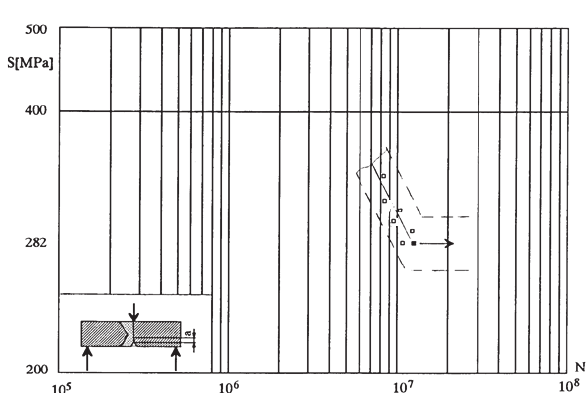
Figure 5: S-N Relationship for specimens with initial crack a = 0.351